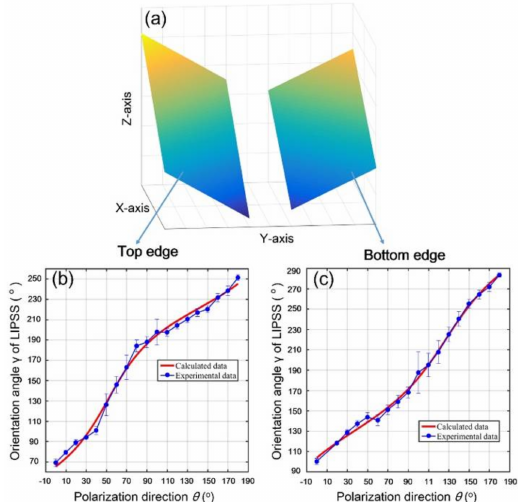
Figure 6. ( a ) Theoretically retrieving the inclined surfaces on the top and bottom edges of the laser-scanned area in the coordinate system of X-Y-Z, with the help of the calculated parameters of ( p top = − 0.6399, q top = − 0.8141) and ( p bottom = − 0.5077, q bottom = 0.6690), respectively; ( b , c ) compare the simulation results with the experimental data for the ripple orientation angles on the top and bottom edges of the laser-scanned area, respectively.